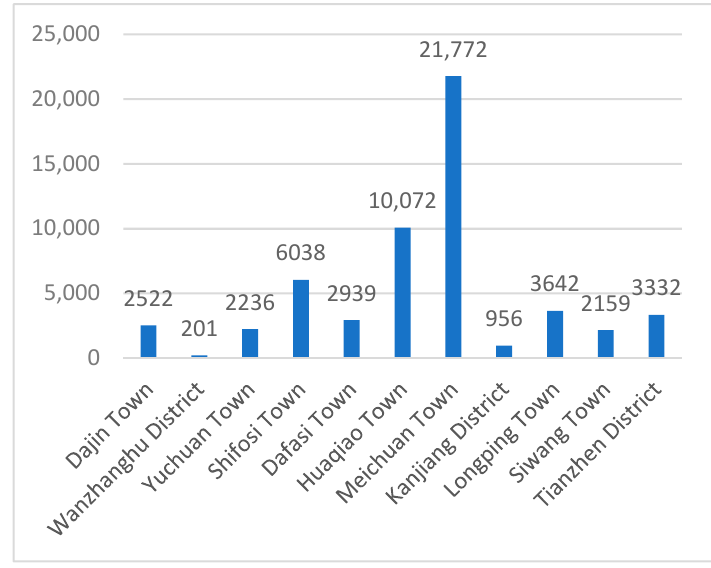
Figure 8. Internal travel OD statistics for each town.